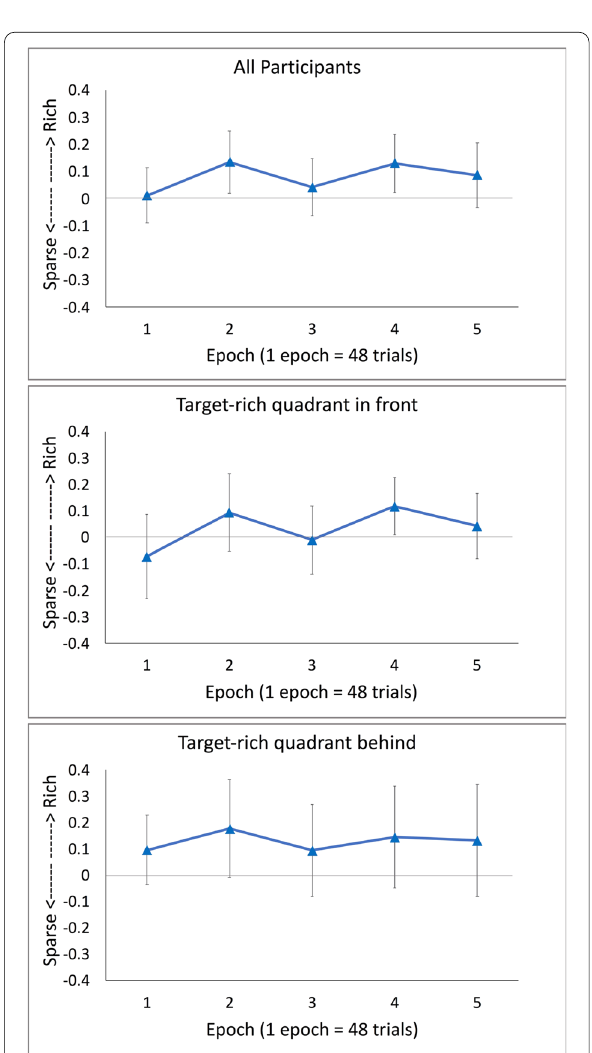
Fig. 3 Average direction of first head turn across trials within an epoch for all participants (top), for participants with a target-rich quadrant in front of them (middle), and for participants with a target-rich quadrant behind them (bottom). Positive values indicate a tendency to turn toward the target-rich quadrant, negative values indicate a tendency to turn away from the target-rich quadrant, and values near 0 indicate the lack of a consistent tendency to turn clockwise or counterclockwise at the start of a search trial. Bars represent standard error of the